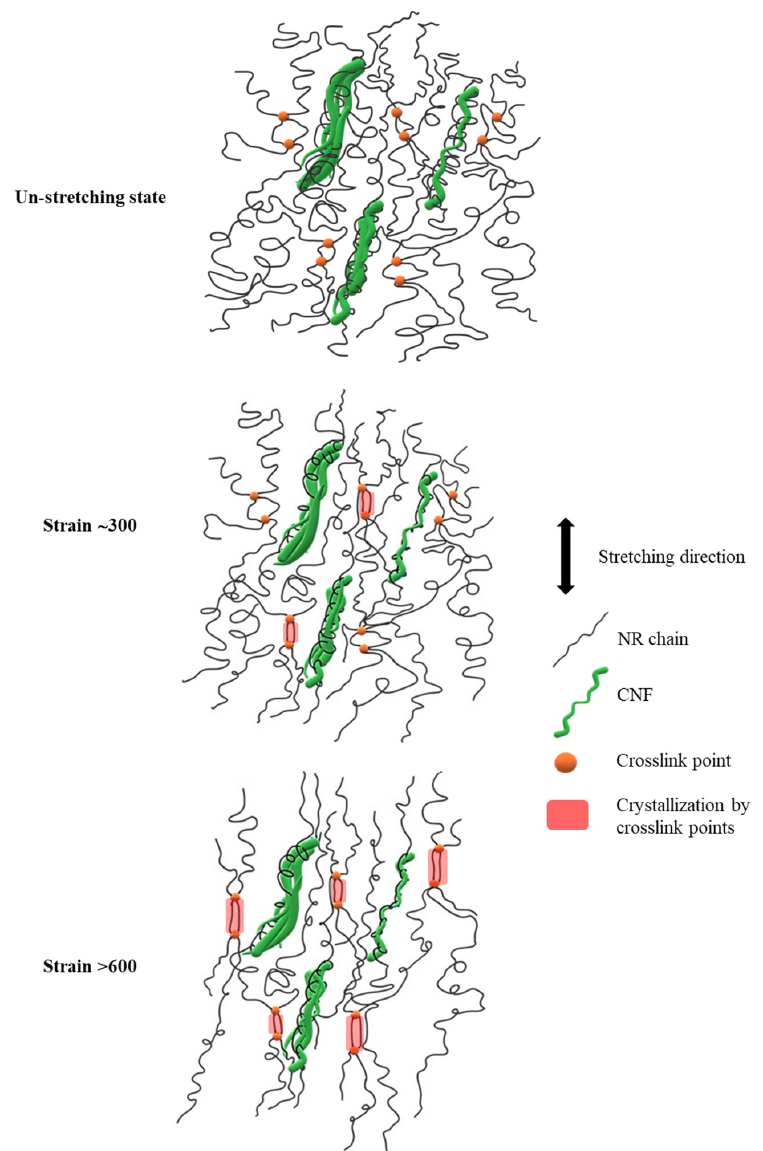
Figure 9. Proposed model for the strain-induced crystallization mechanism of the CNF/NR nanocomposite with 1 phr CNF.